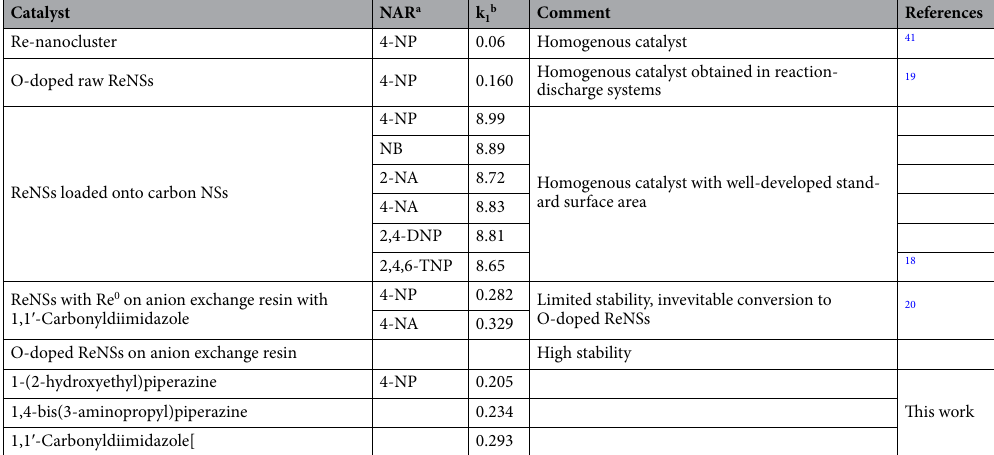
Table 3. Efficiency of Re-loaded pNCs in the catalytic reduction of NARs. a Nitroaromatic compound; 4-NP: 4-nitrophenol; NB: nitrobenzene; 2-NA: 2-nitroaniline; 4-NA: 4-nitroaniline; 2,4-DNP: 2,4-dinitrophenol; 2,4,6-trinitrophenol. b Pseudo-first order rate constant (min −1